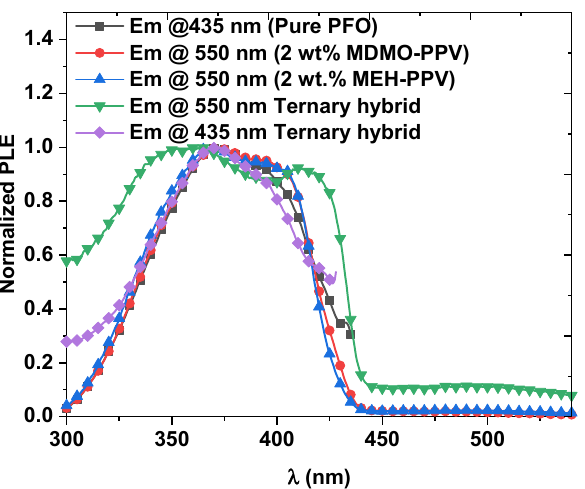
Figure 7. Normalized PLE spectra of pure PFO and the optimal ratios of binary and ternary hybrids at emission wavelengths of 435 and 550 nm.